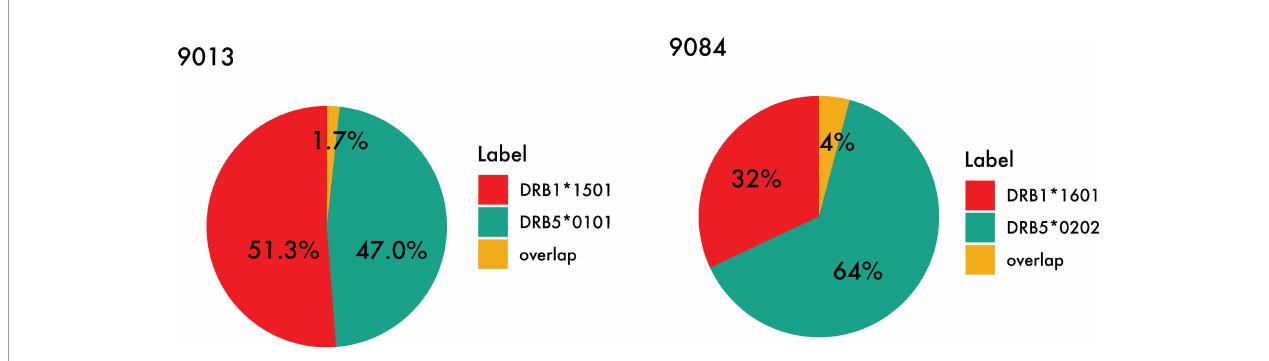
FIGURE 7 | Peptide overlap within the DR51 haplotype group. HLA-DR binding for MS ligands identi fi ed within the two DR51 cell lines (Left) 9013 (HLA- DRB1*15:01 and HLA-DRB5*01:01) and (Right) 9084 (HLA-DRB1*16:01 and HLA-DRB5*02:02) was predicted with NetMHCIIpan-4.1 using a threshold of 1% rank, and the relative contribution from each primary and secondary HLA-DR molecule as well as their overlap were